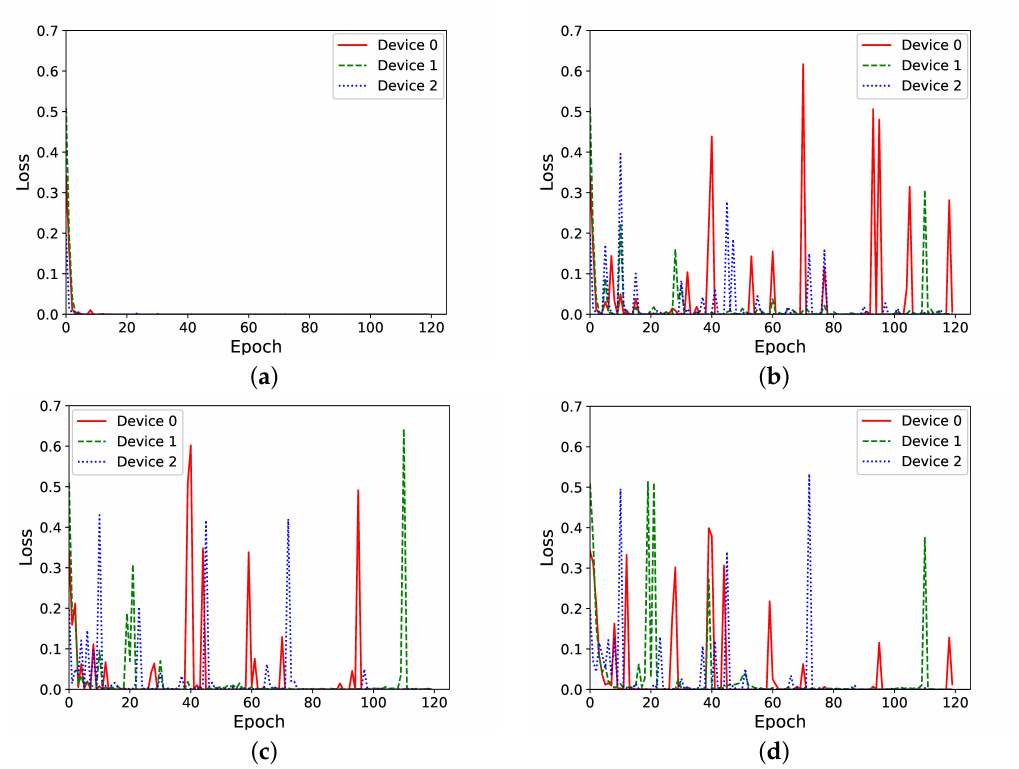
Figure 8. Loss in function of the number of epochs during the non-IID data training process, for different numbers of federated learning rounds. ( a ) One different keyword per client, no federated learning. ( b ) Non-IID data, federated learning every 5 epochs. ( c ) Non-IID data, federated learning every 2 epochs. ( d ) Non-IID data, federated learning every 1